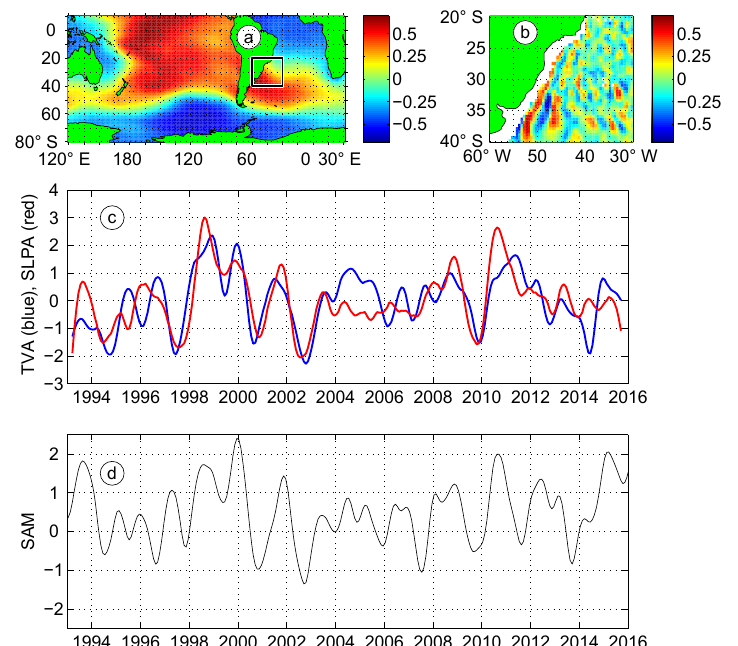
Figure 10. First mode of coupled EOF of the anomaly of the meridional transport (TVA) from Argo&SSH (in the box centered at 30 ◦ S, 45 ◦ W) and the anomaly of the sea level pressure (SLPA) from MERRA. The time series were filtered using a 6-month cutoff period, and the mean annual cycle was subtracted. The spatial patterns of the heterogeneous correlation maps are presented in (a) . The homogenous correlation (b) , the normalized time series of the expansion coefficients (c) and the SAM index (d) are shown as well. The correlation between the expansion coefficients is 0.7, which is significant with respect to the 95% confidence